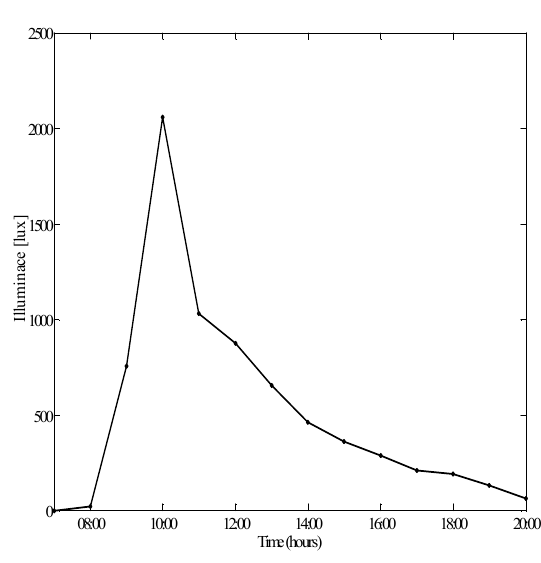
Figure 2. Illuminance of daylight on the work plane